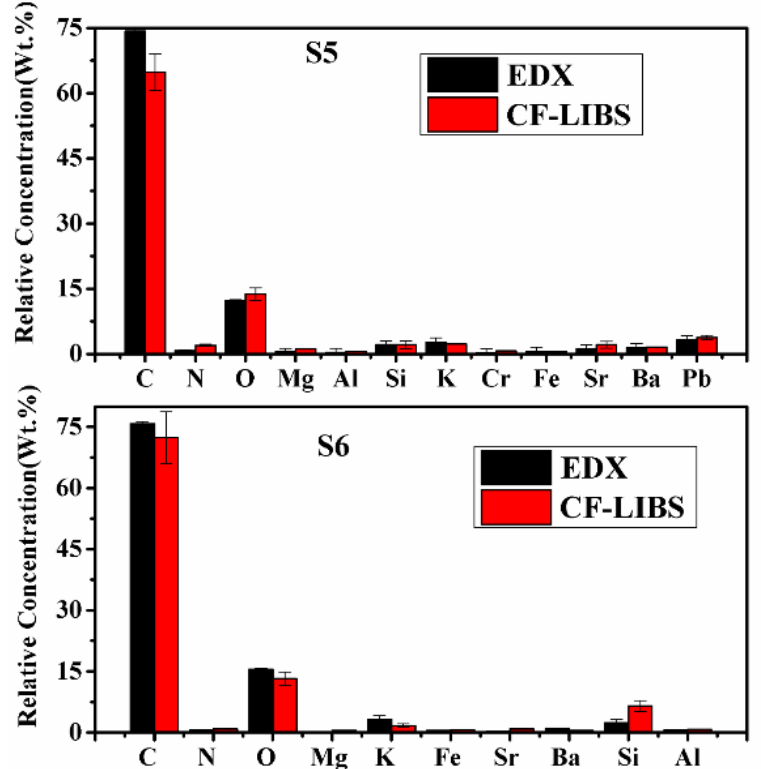
Figure 12. Relative concentrations of compositional elements of C. longa (turmeric powder) as measured by CF-LIBS and EDX